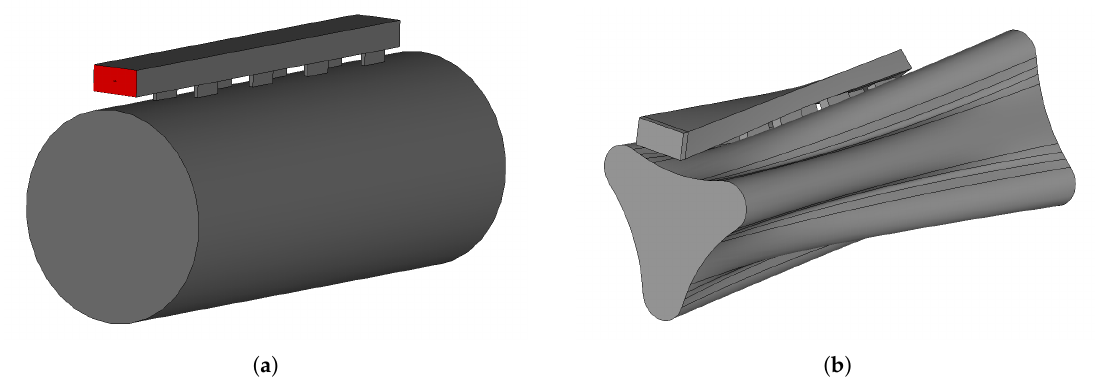
Figure 8. Slotted waveguide injection system coupled to: ( a ) standard cylindrical and ( b ) “plasma-shaped” cavities. Simulations have been made by using vacuum volumes.